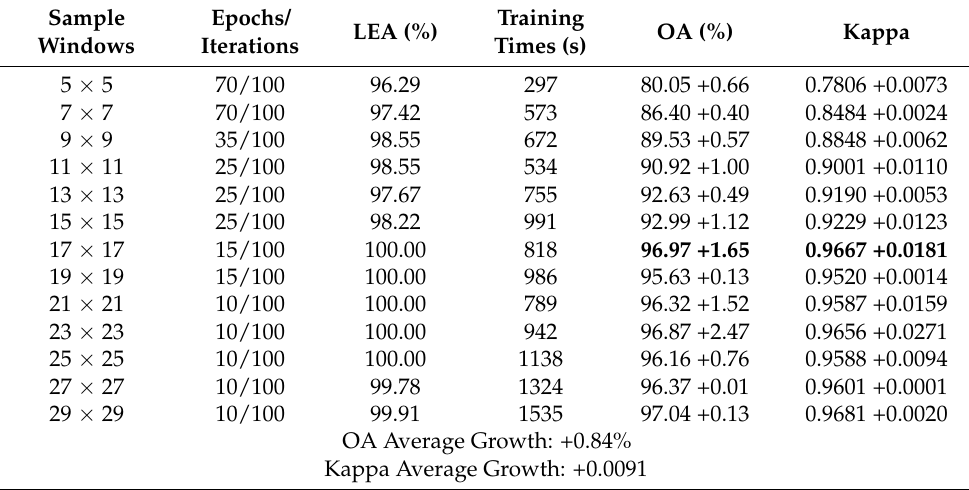
Table 7. Classification accuracy of